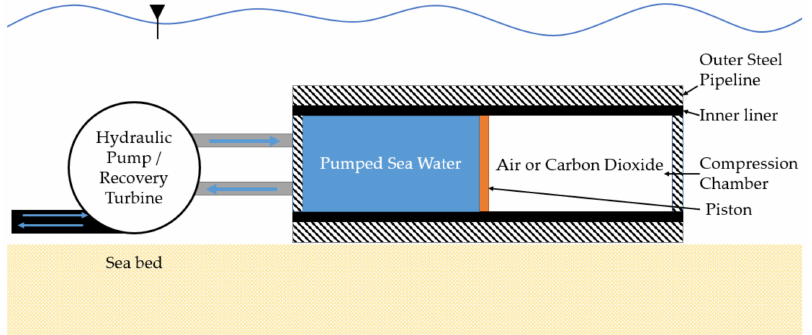
Figure 1. Accumulator cross-section placed subsea on the seabed while including both the hydraulic pump and the recovery